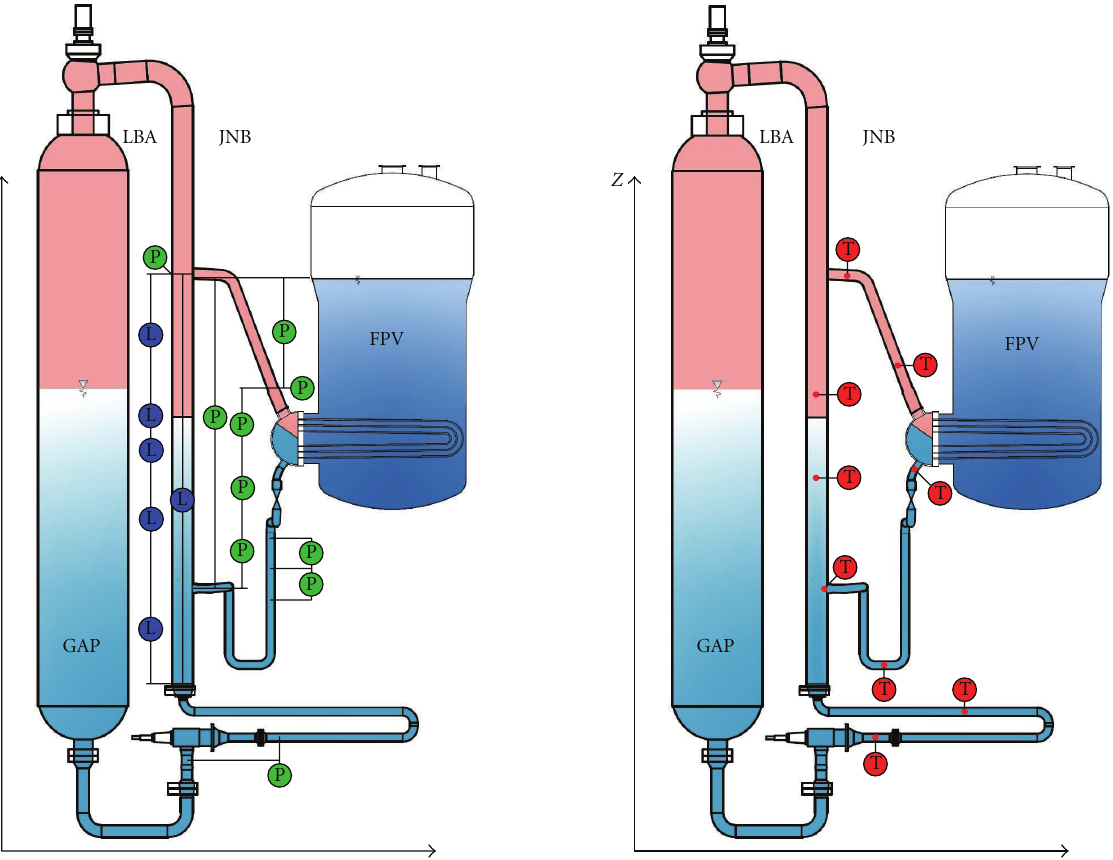
Figure 10: Instrumentation of the Emergency Condenser System